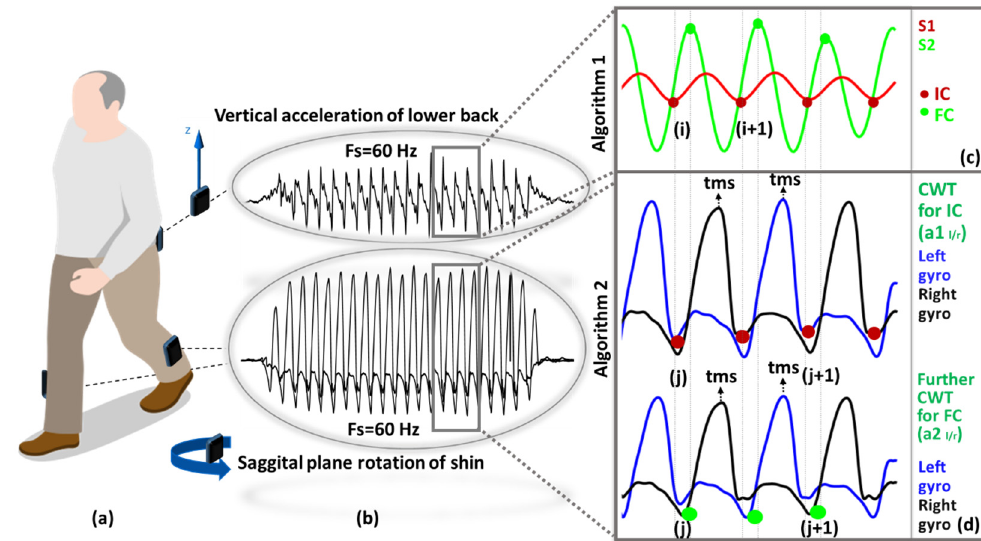
Figure 1. Data processing: ( a ) Sensor placement, ( b ) raw acceleration and rotation data of two different location, ( c ) IC-FC detection with Algorithm S1 (in Supplementary Material) process, ( d ) IC-FC detection with Algorithm S2 (in Supplementary Material), ICs and FCs are represented with red and green dots, respectively.